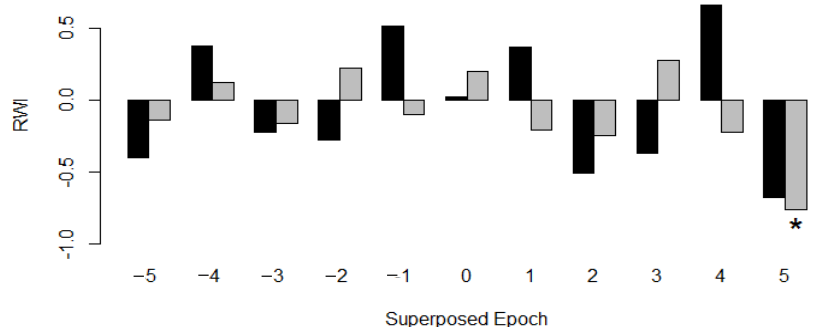
Figure 7. Drought year analysis (superposed epoch analysis) of the ring width index (RWI) during drought years (0), pre ‐ drought ( − 5 to − 1) and after drought (1–5) for Robinia pseudoacacia (black) and Tilia cordata (gray) in Würzburg. Input drought years are 2012, 2003, 1993, 1976, and 1964 for R. pseudoacacia and 2012, 2003, 1976, and 1947 for T. cordata . Marked columns (asterisk) represent a departure that is greater than would have occurred randomly as determined from 1000 bootstrap simulations at p < 0.05.